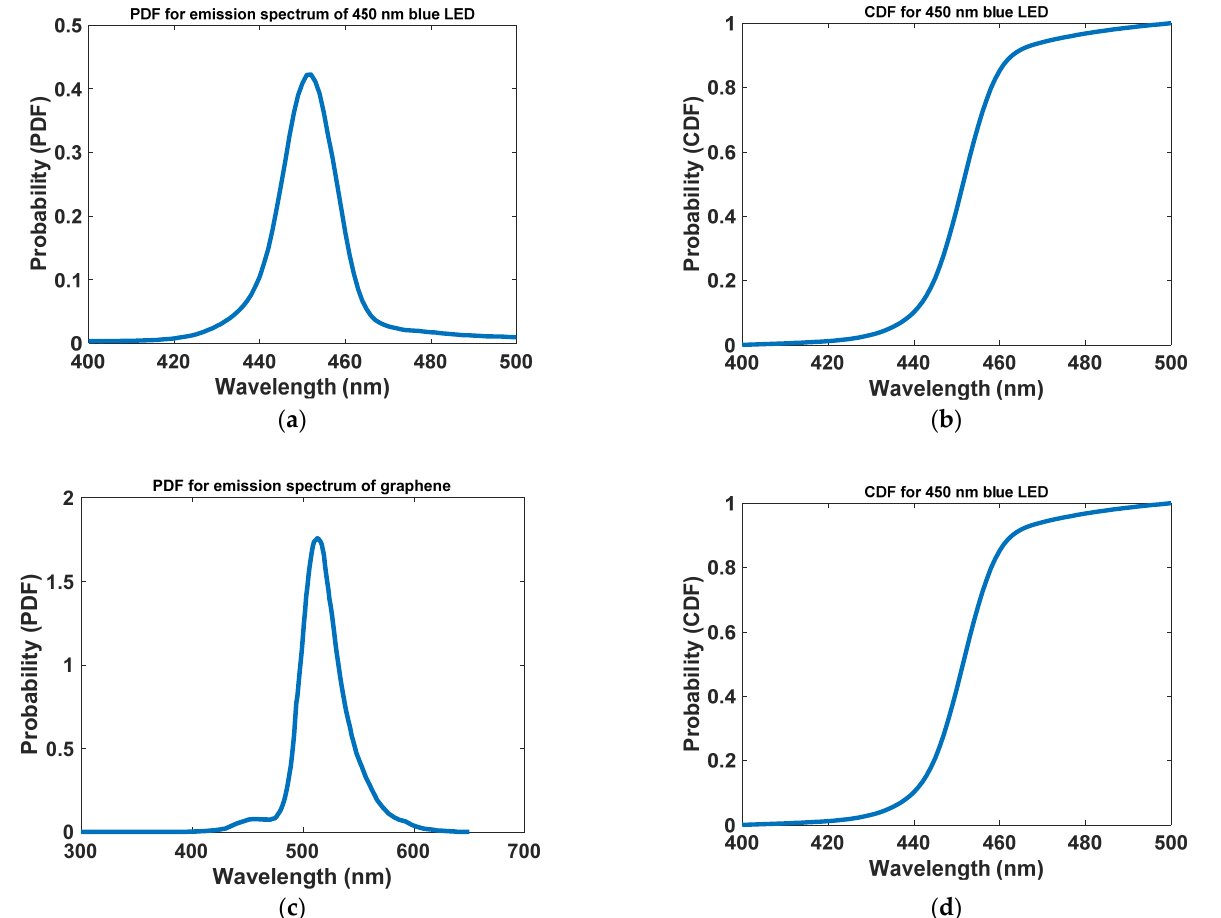
Figure 5. Probability density function (PDF) and cumulative distribution function (CDF) for blue 450 nm LED ( a , b ) and graphene quantum dots ( c , d ) respectively. 3. The CDF is defined as the area of the PDF curve until the i -th term, to the whole area of the PDF. Equation (2) depicts the relation applied to calculate the area under the curve, where λ j is the j -th term of the wavelength, and k is the wavelength vector’s length. Figure 5b points out the CDF of the 450 nm blue LED. In total, 100,000 initial photons with uniform distribution on the upper surface of LSC and flood illumination are assumed during this simulation. The upper flat surface of LSC encounters a typical incidence, while the upper inclined surface will have the incident light with a non-zero input angle. This is calculated by using trigonometric relations. Some percent of initial photons are reflected from the upper surfaces of LSC results from the different refractive index for waveguide and the surrounding medium.